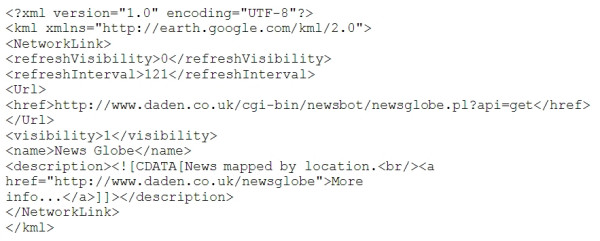
'Network link' file.